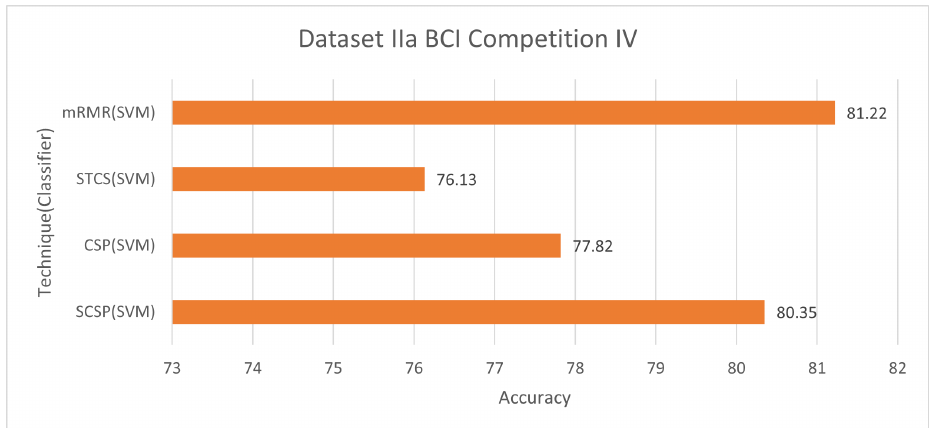
Figure 11. Accuracy by different techniques for Dataset IIa BCI Competition IV.